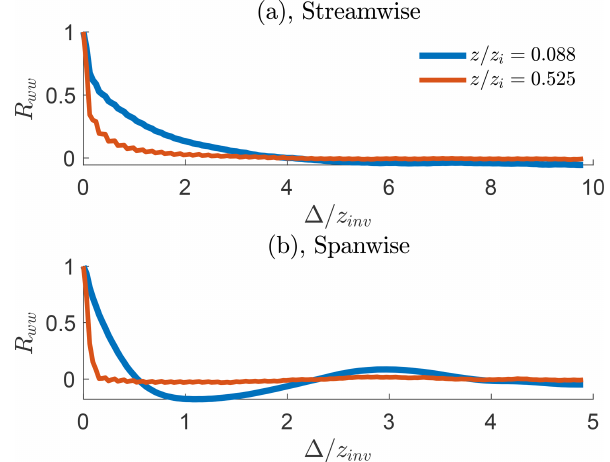
Figure 5. Two-point correlation of vertical velocity variance R ww in the (a) streamwise and (b) spanwise direction for z/z inv = 0 . 088 (red) and z/z inv = 0 . 525 (blue). (cid:49) is the spatial distance dependent on the coordinate direction, nondimensionalized by the inversion height, z inv